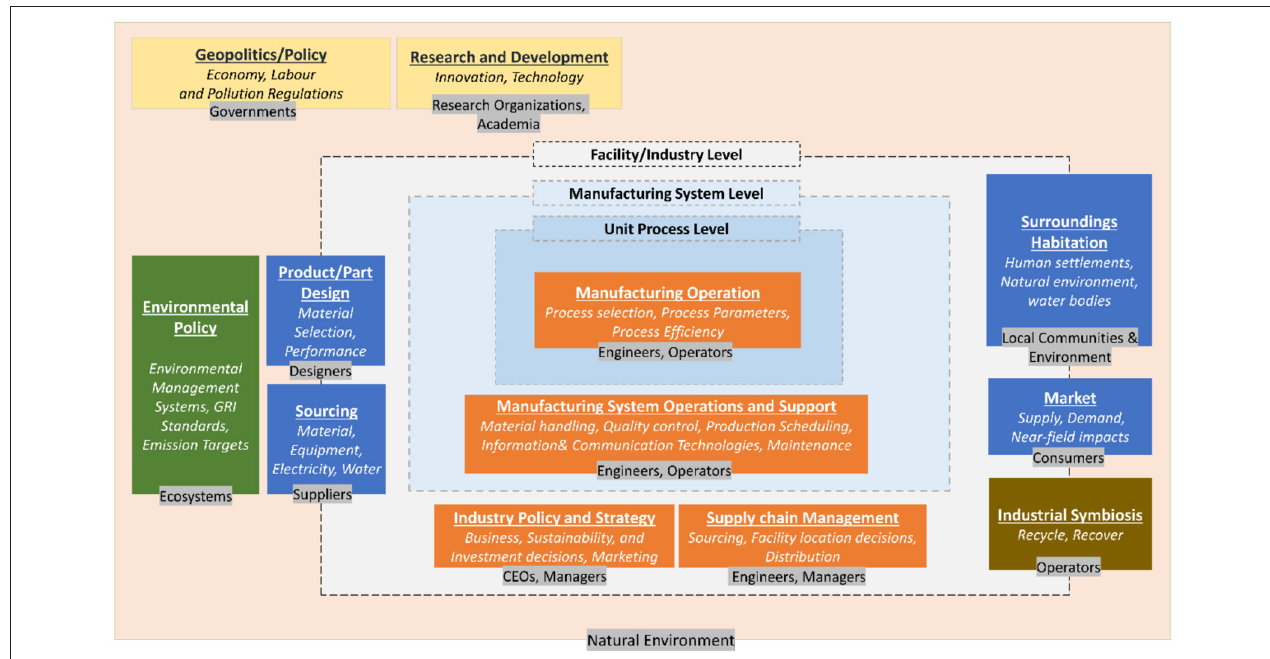
FIGURE 1 | Levels of manufacturing, decision-makers (gray shaded) involved and their roles, and surrounding entities affecting manufacturing operations (derived from Kumar and Mani,